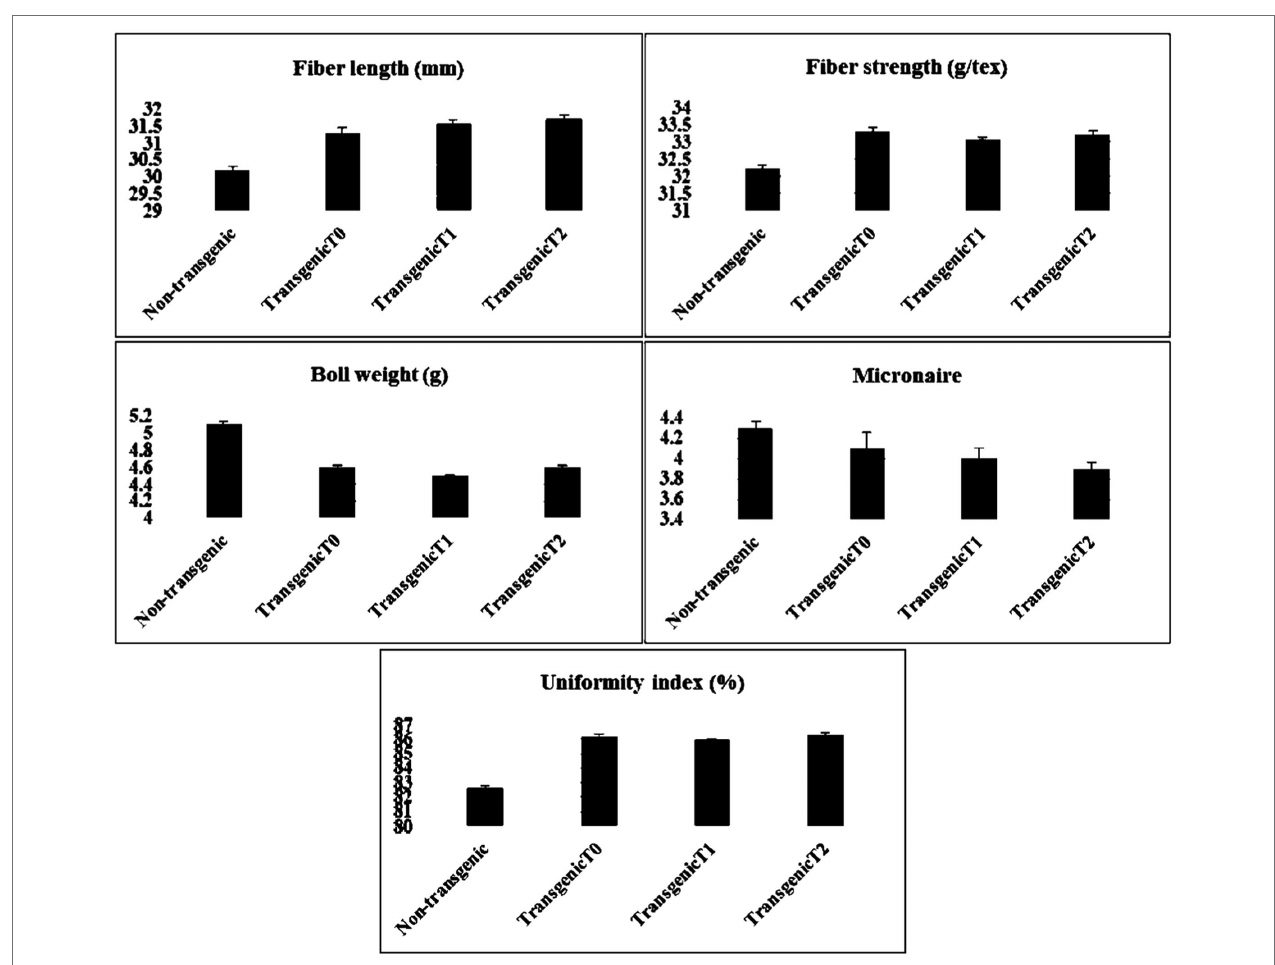
FIGURE 10 | Comparative analysis of the fiber quality parameters in transgenic (T0, T1, and T2) and non-transgenic cotton plants three each. Fiber quality appeared to be improved owing to the expression of the